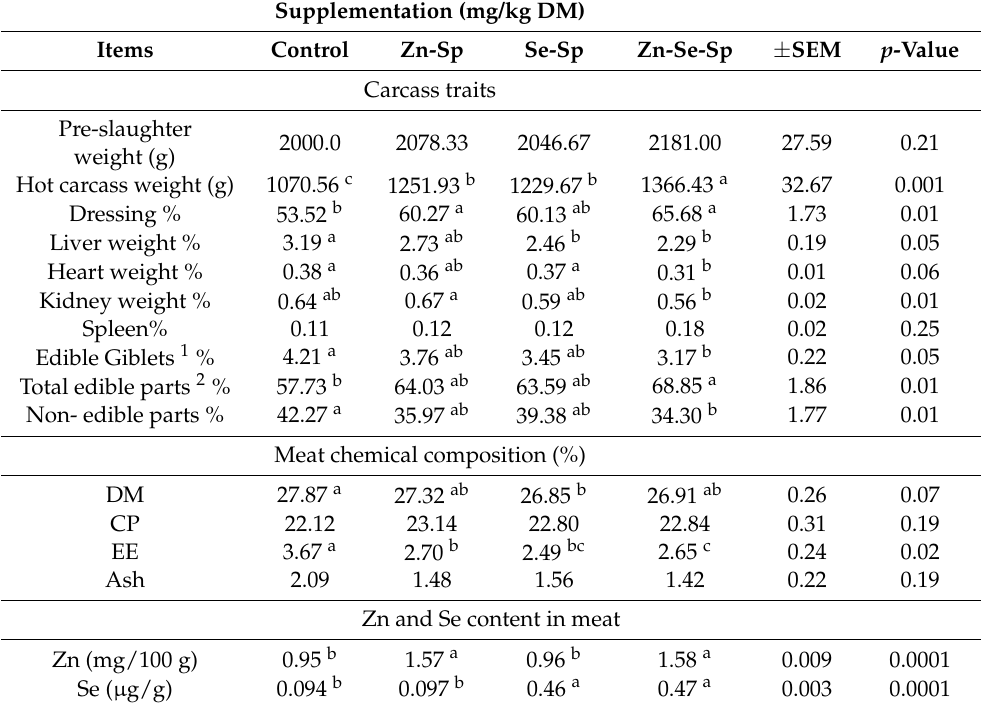
Table 4. Effect of different experimental diets on carcass traits and meat chemical composition of growing rabbits. Supplementation (mg/kg DM) Items Control Zn-Sp Se-Sp Zn-Se-Sp ± SEM p -Value Carcass